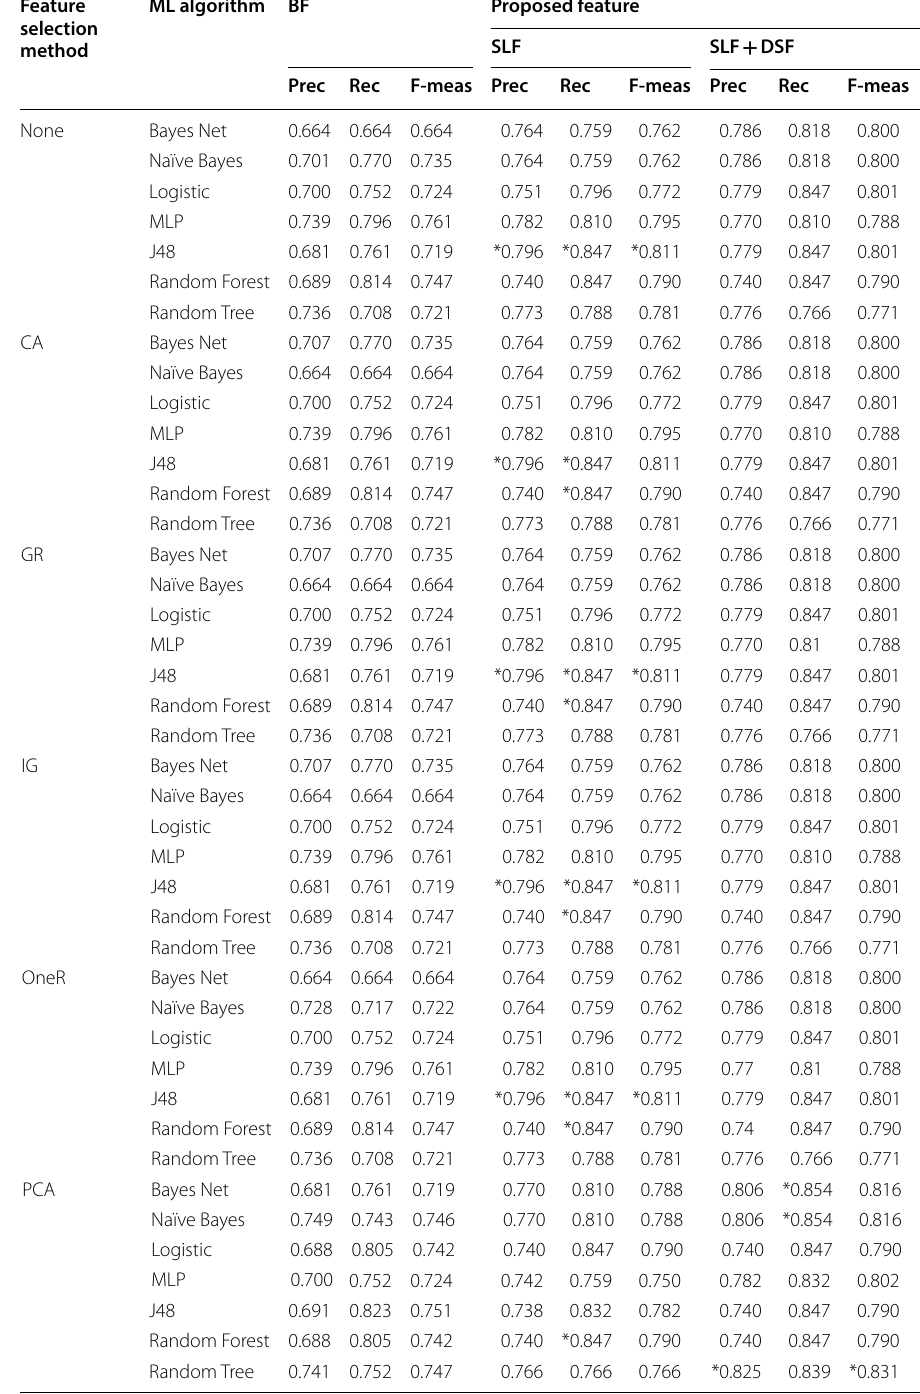
Table 9 Result of the experiment using automobile dataset Feature